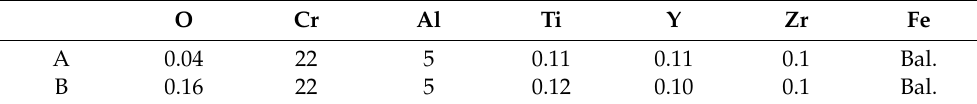
Figure 1. Schematic diagrams of ( a ) powder cans and ( b ) tensile samples (in mm). Table 1. Chemical composition of the as-HIPed ODS steels (wt%).